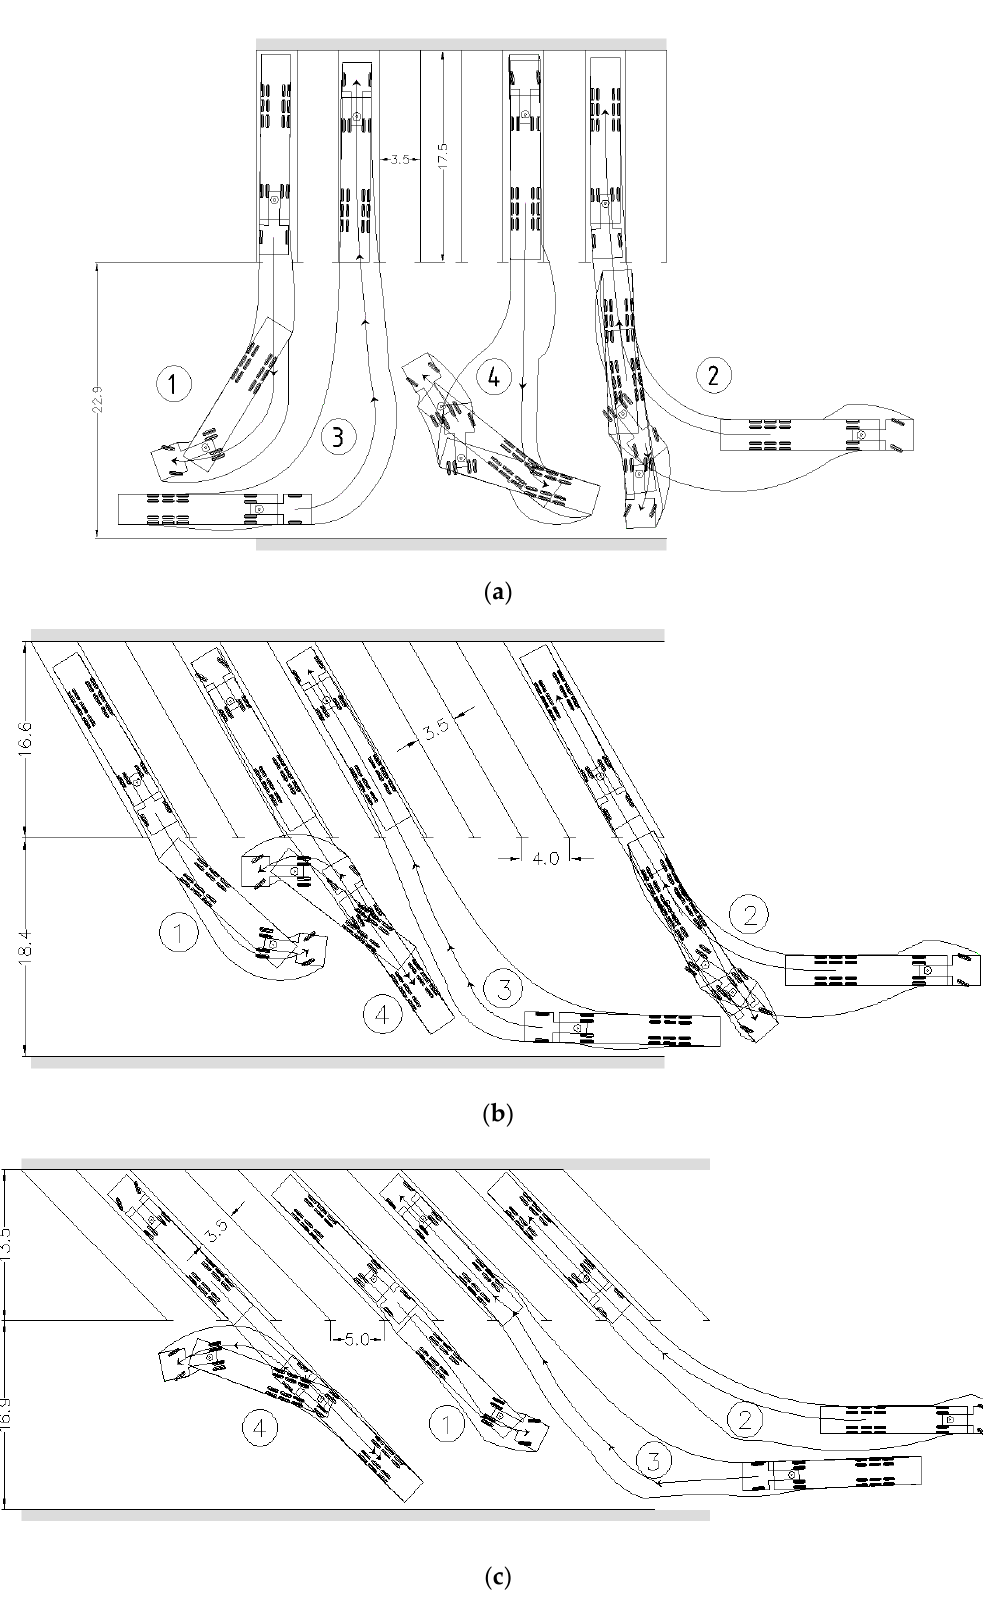
Figure 8. Manoeuvring schemes for a large goods vehicle (16.5 m) in a parking: ( a ) location of the parking space at an angle of 90 ◦ ; ( b ) location of the parking space at an angle of 60 ◦ ; ( c ) location of the parking space at an angle of 45 ◦ ; 1—way forward; 2—backing; 3—forward ride; 4—reversing.